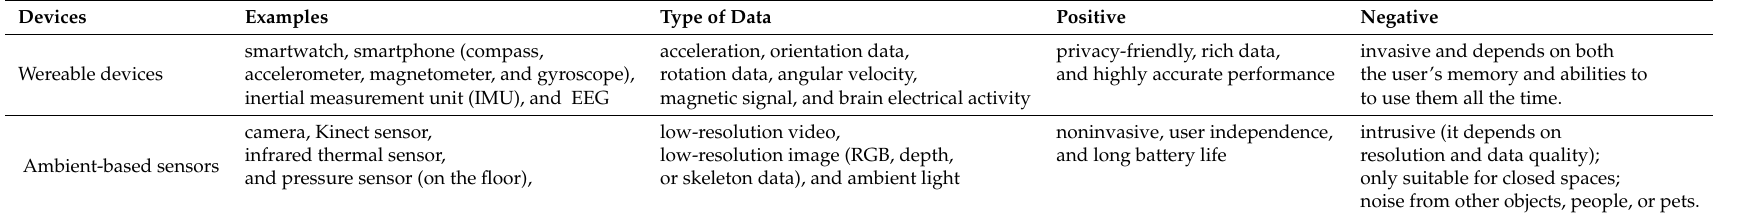
Table 1. The main types of devices that collect fall datasets and their positive and negative